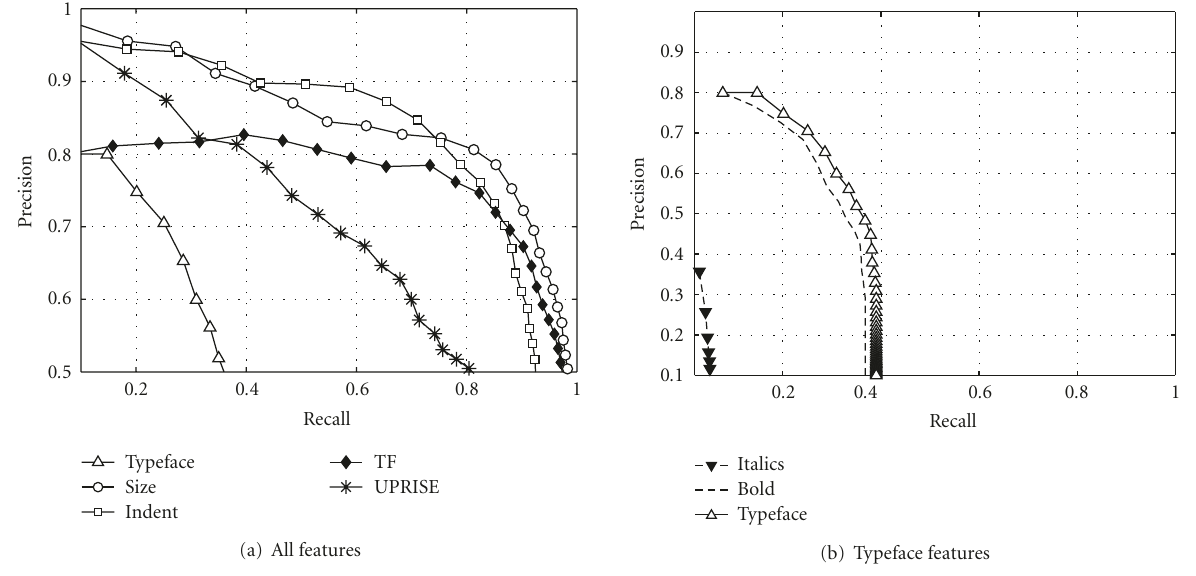
Figure 9: Precision-recall curves for the proposed features: size, indentation, typeface, and term frequency.